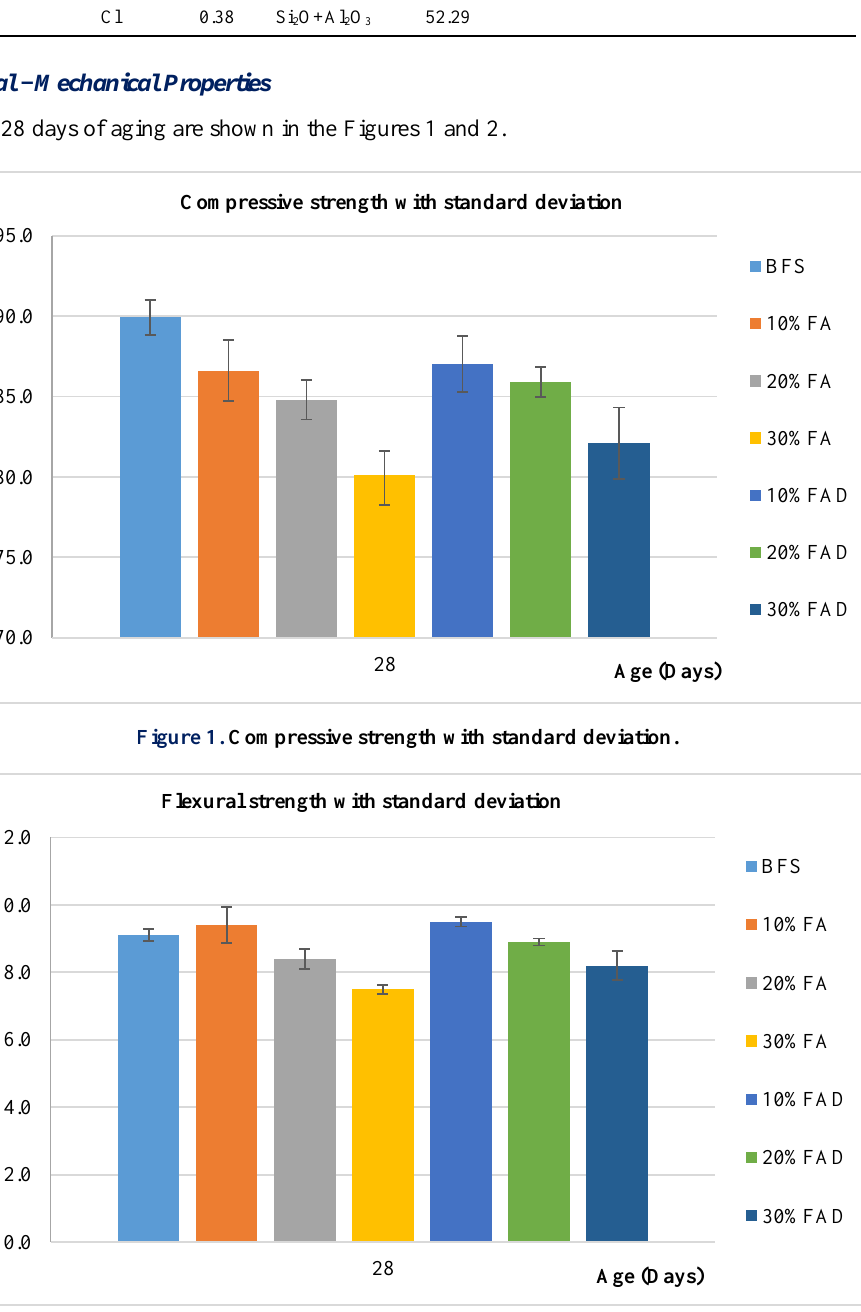
Figure 2. Flexural strength with standard